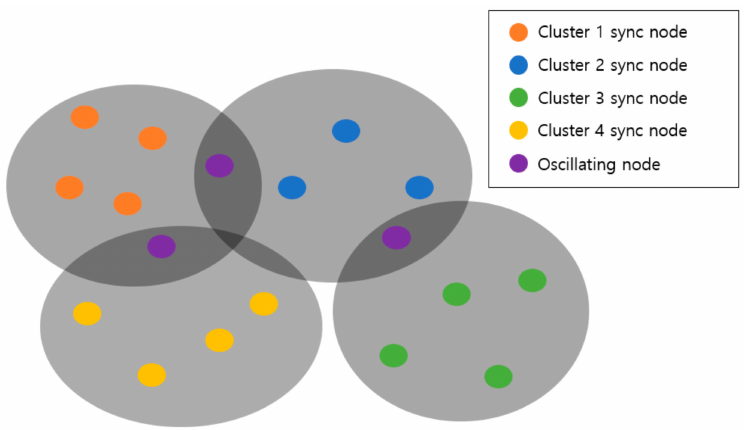
Figure 3. Exemplified network with four clusters and oscillating